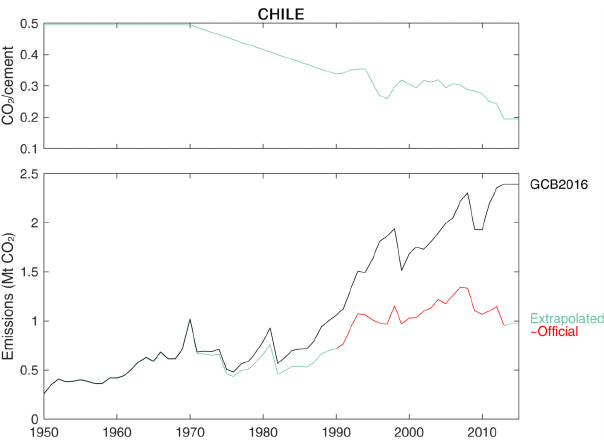
Figure D16. Revised cement emissions for Chile.